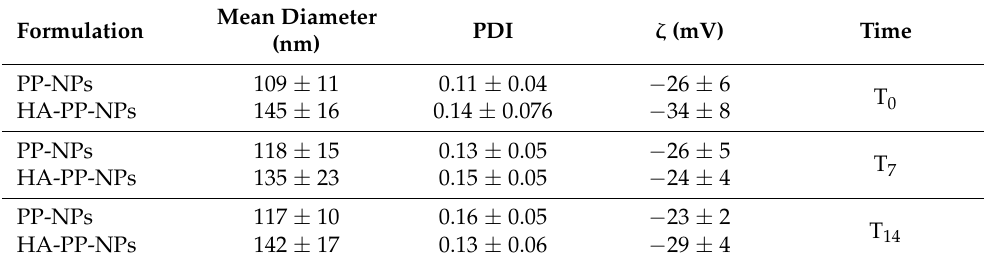
Table 1. DLS measurements at T 0 , T 7 , and T 14 .